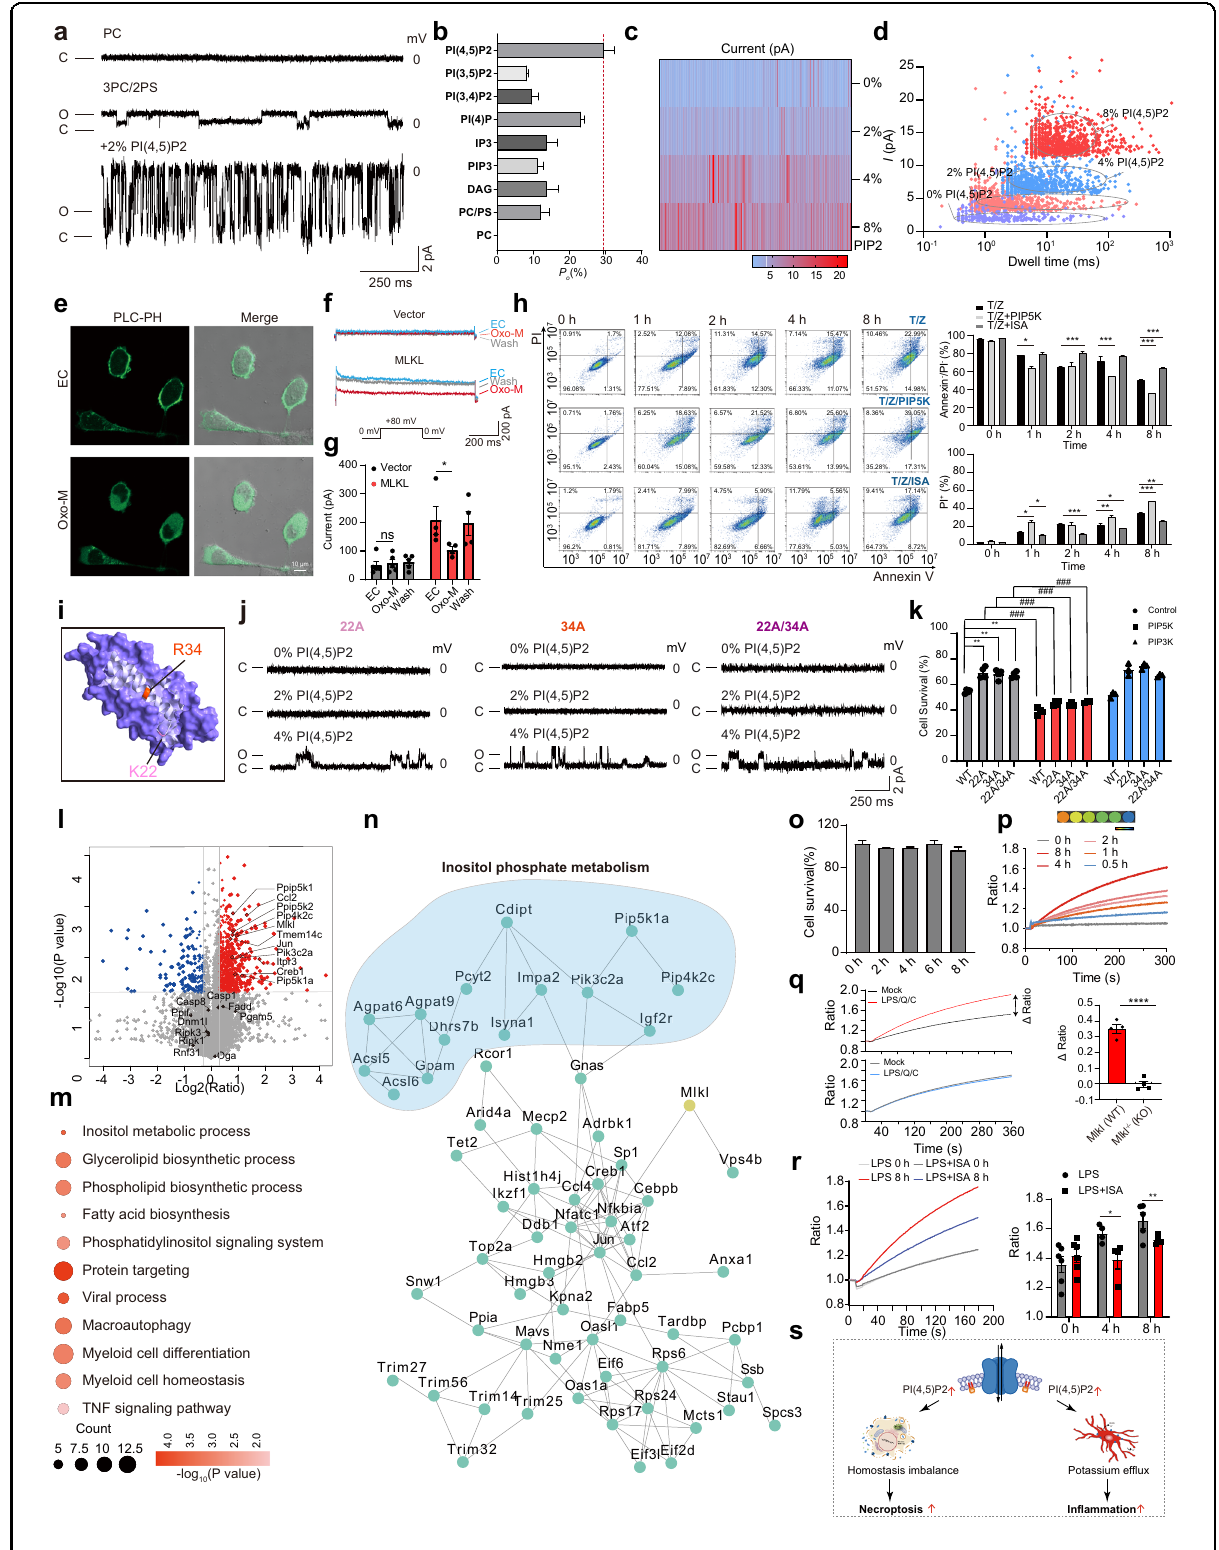
Fig. 1 (See legend on next